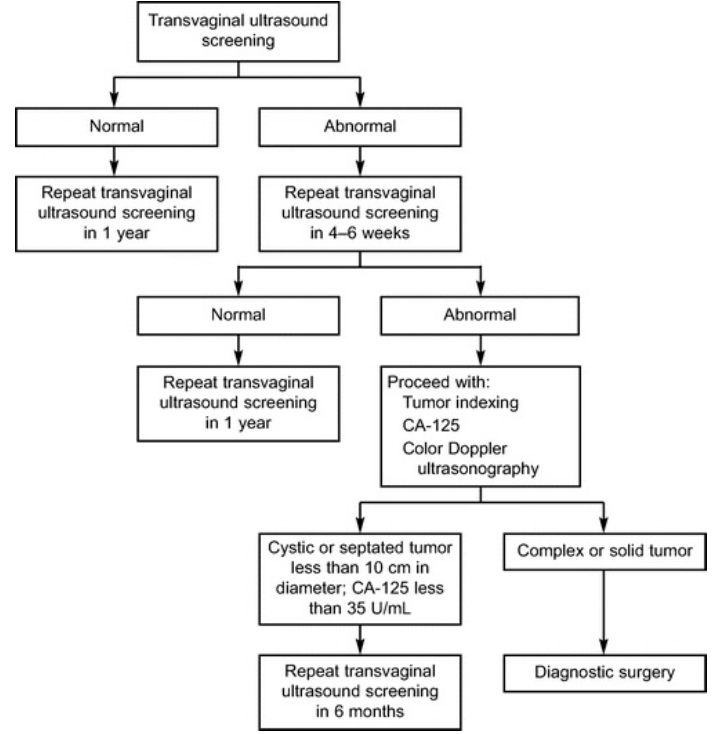
Figure 1. University of Kentucky Ovarian Cancer Screening Trial screening, evaluation, and treatment algorithm [53]. Reproduced with permission from publisher .